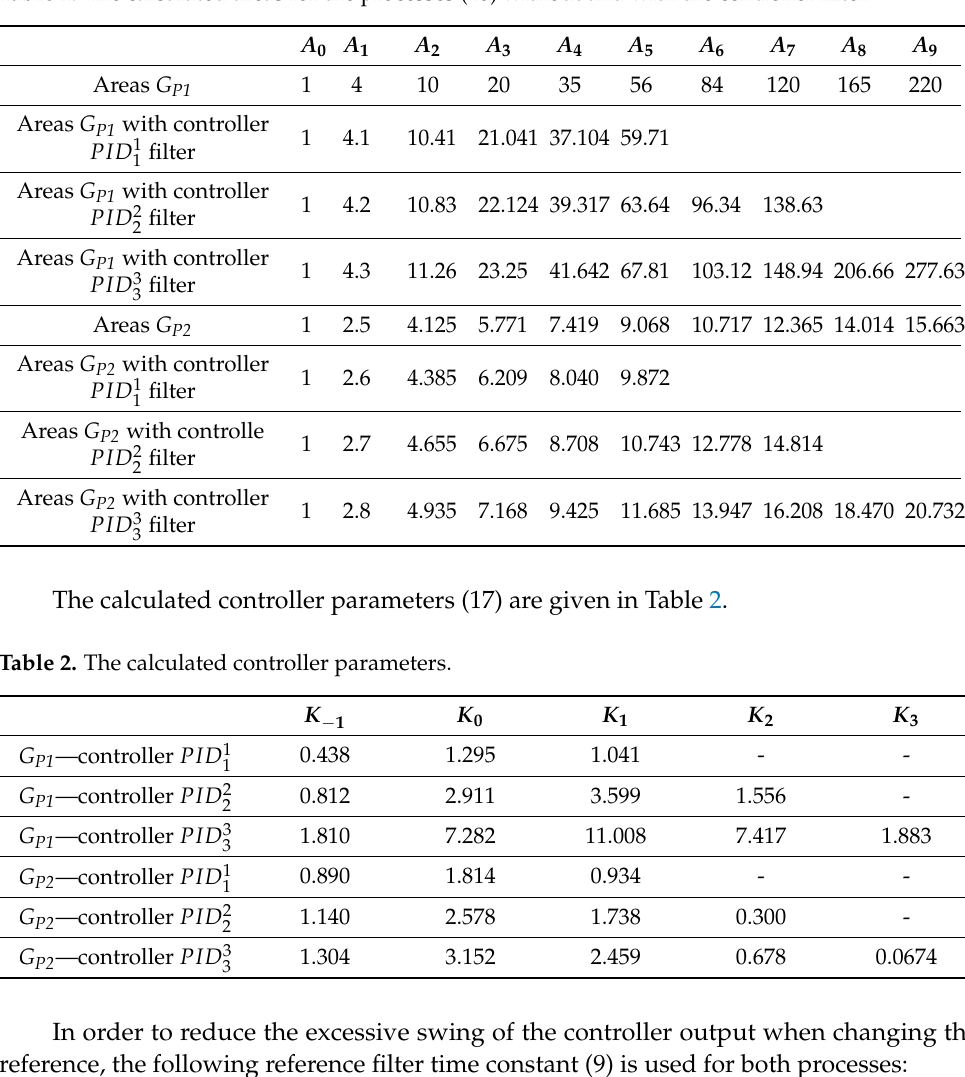
Table 1. The calculated areas for the processes (18) without and with the controller filter.